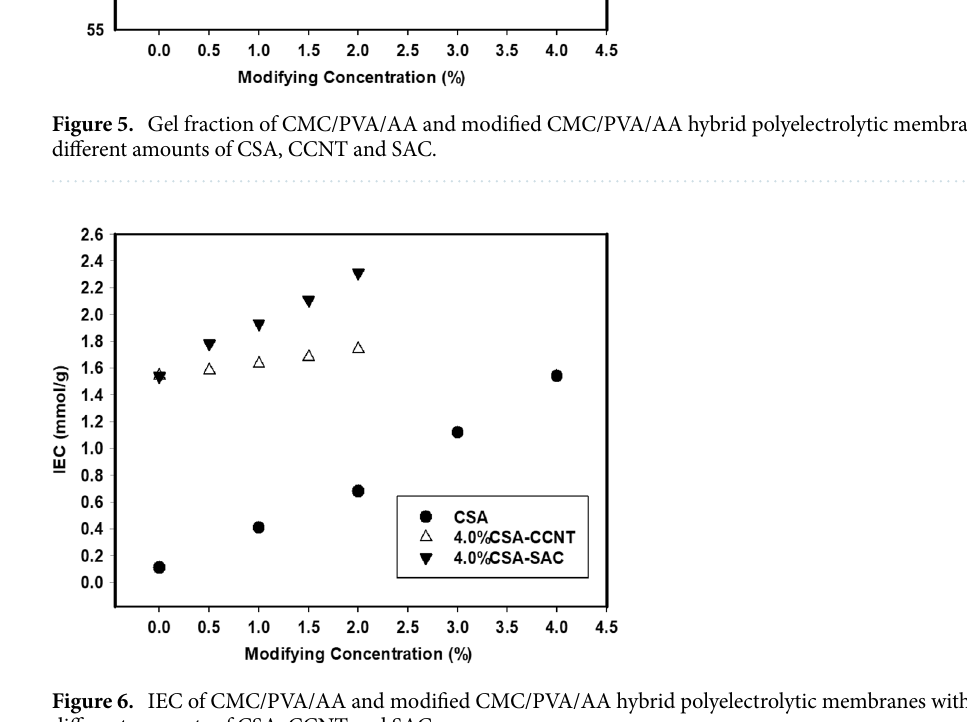
Figure 6. IEC of CMC/PVA/AA and modified CMC/PVA/AA hybrid polyelectrolytic membranes with different amounts of CSA, CCNT and